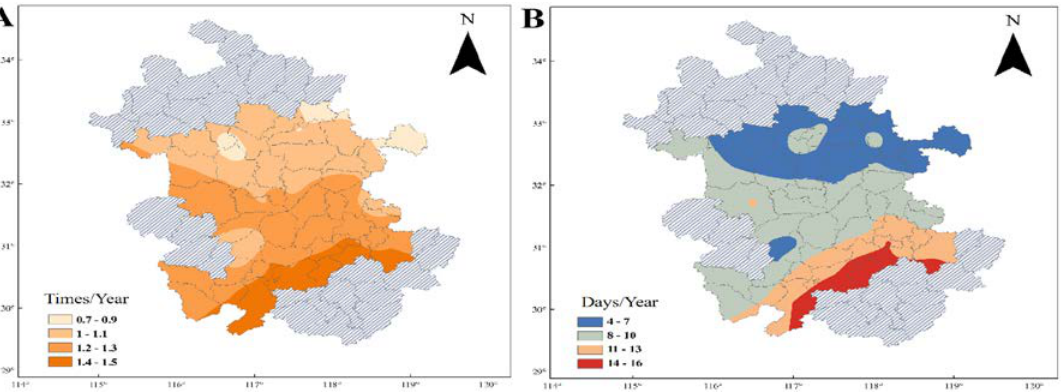
Figure 3. Spatial distribution of high-temperature damage during heading and flowering of mid- season rice in Jianghuai from 1961 to 2018. ( A ) Frequency per year. ( B ) The number of days per year.